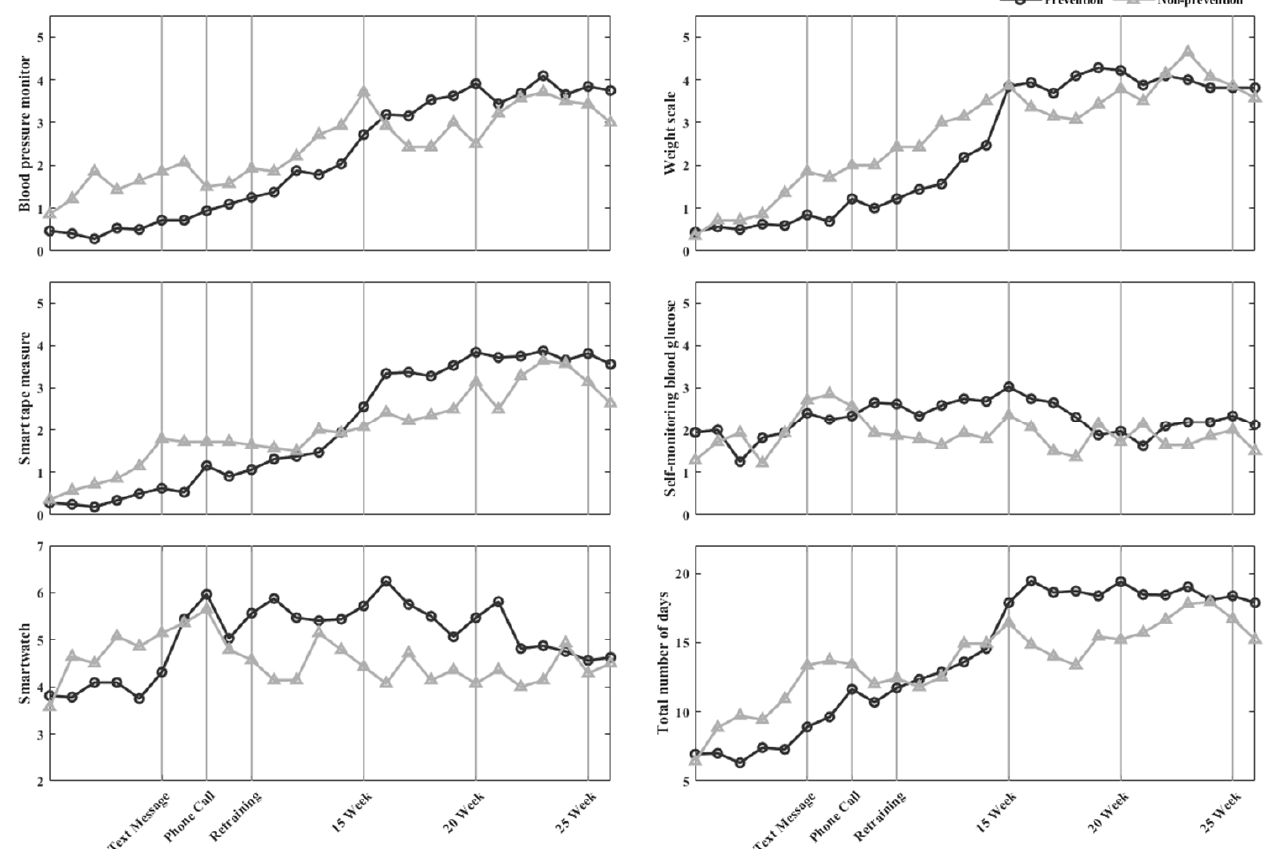
Figure 2. In pre-MetS, the number of days healthcare devices were used per week.